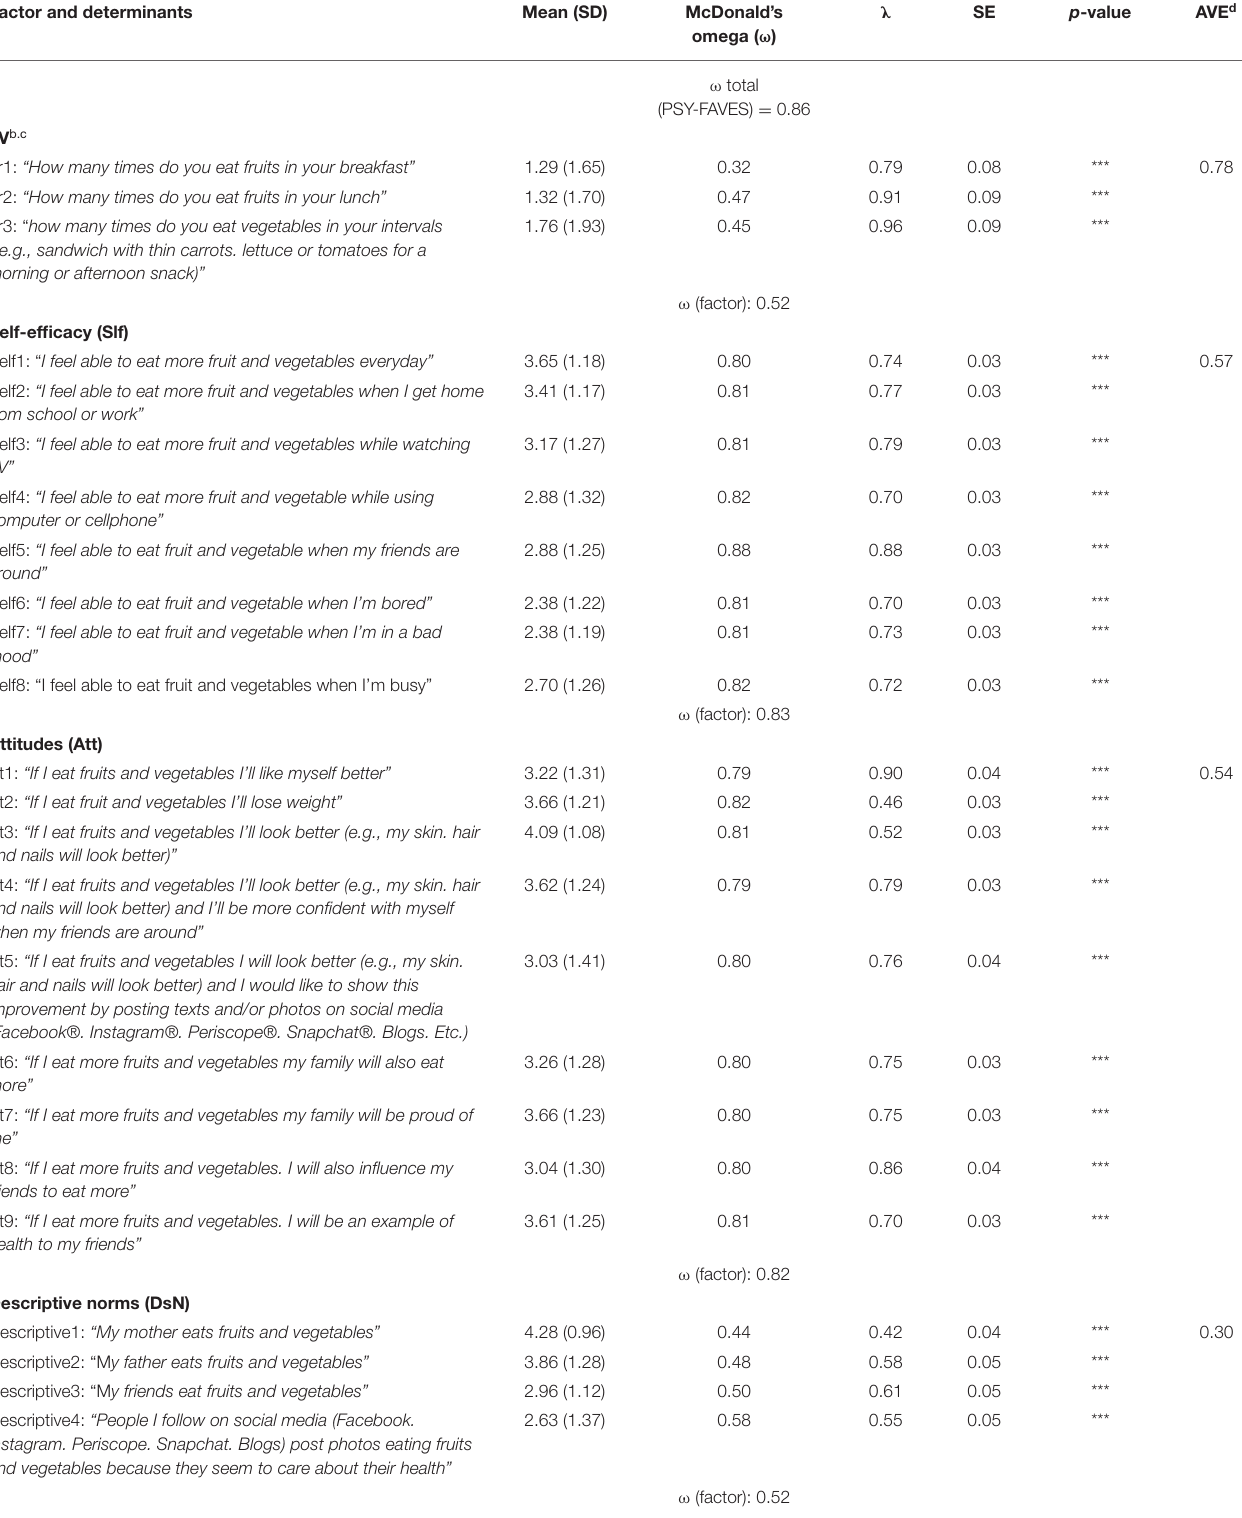
λ SE p -value AVE d omega ( ω ) ω total (PSY-FAVES) = 0.86